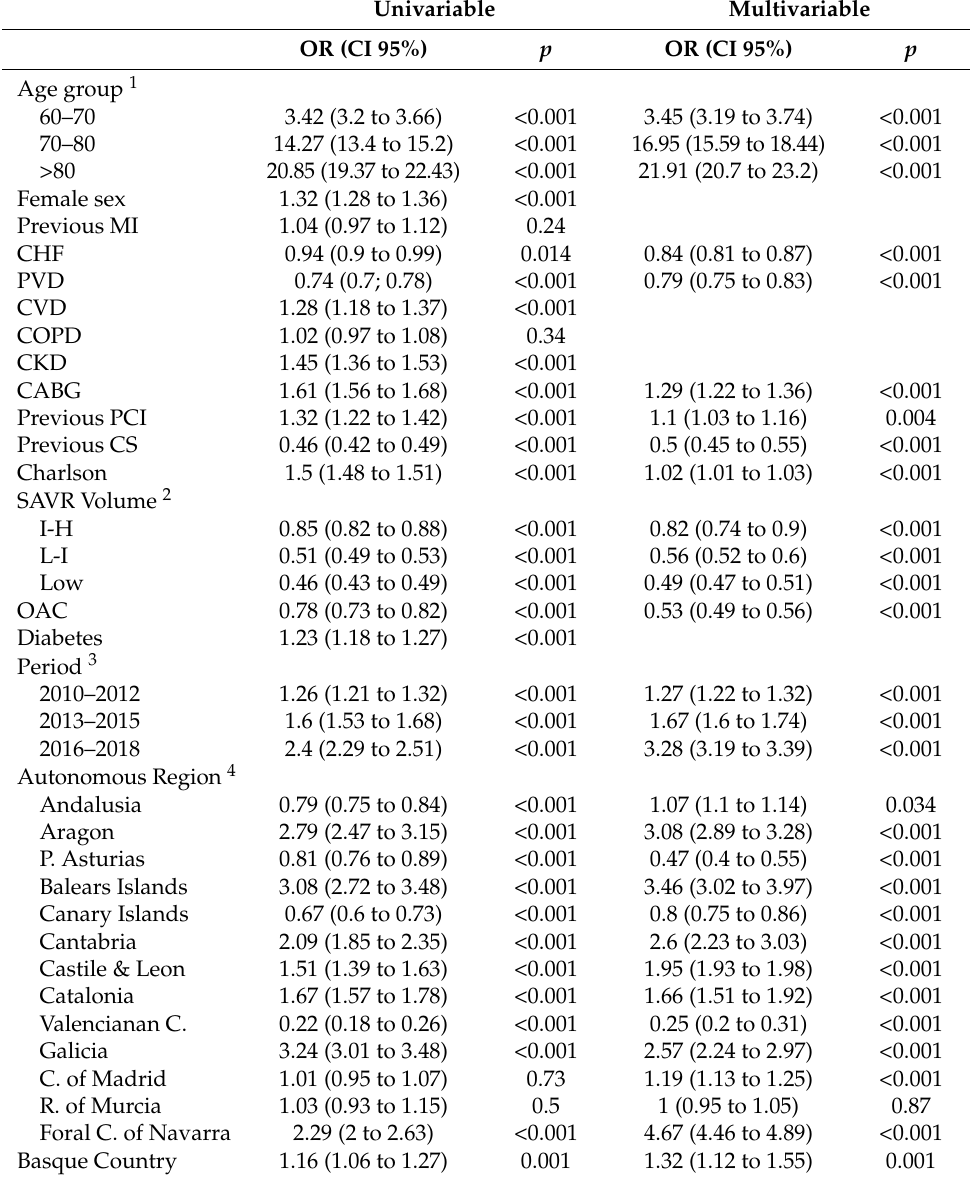
Table 3. Factors associated with tissue valve implantation in patients undergoing SAVR in Spain. Univariable